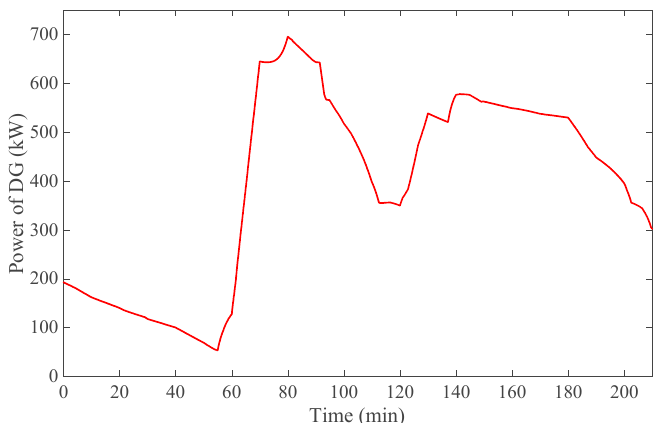
Figure 15. Optimized output power of the diesel generator.